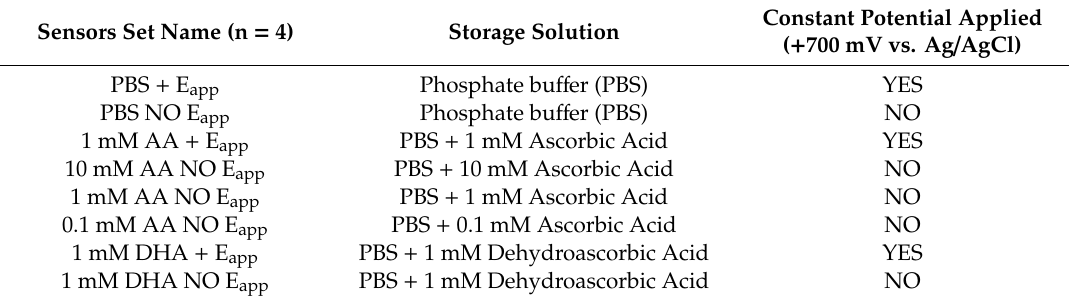
Table 2. Di ff erent storage conditions used for evaluating sensor behavior; sensors set names correspond to Figures 3 and 4 legends.